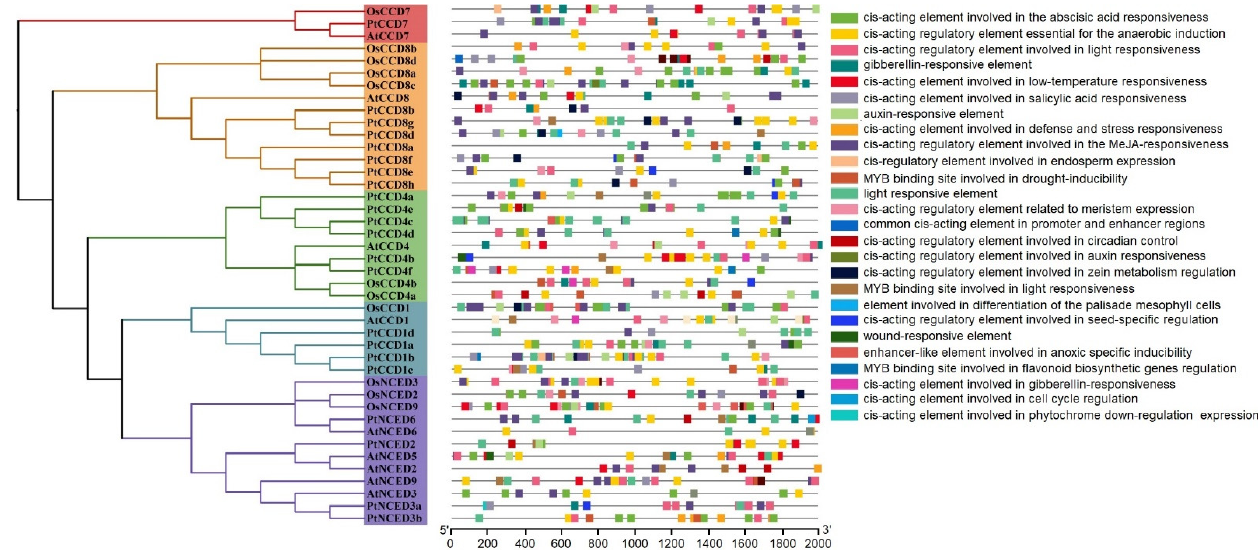
Figure 5. Analysis of poplar and Arabidopsis CCD gene promoter cis-elements. Left panel, the phylogenetic tree constructed by NJ method. Right panel, the kinds of CCD promoter cis-elements displayed using colorful rectangles.